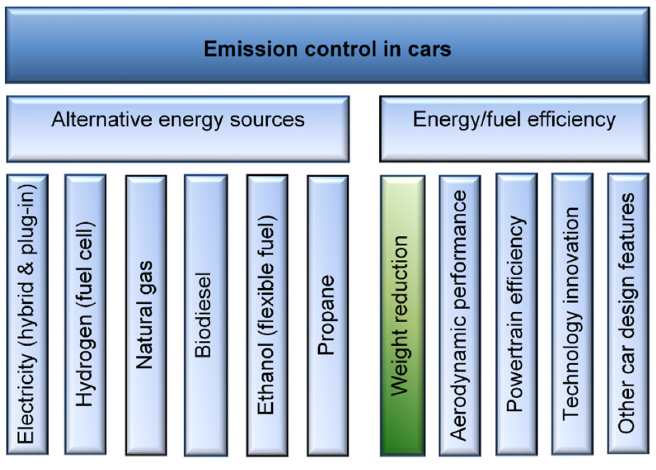
Figure 3 . Major factors affecting the GHG emission in automotive vehicles and the vehicle weight reduction as the contributor.